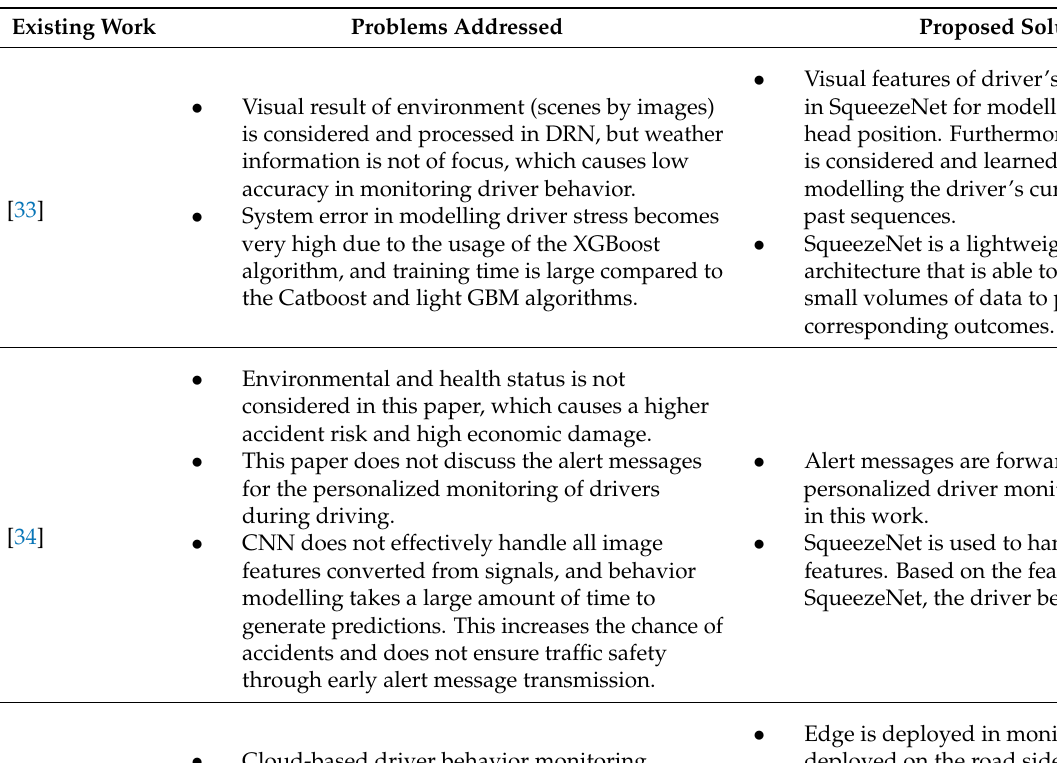
Table 1. Summary of the contribution of the approach and results achieved by other